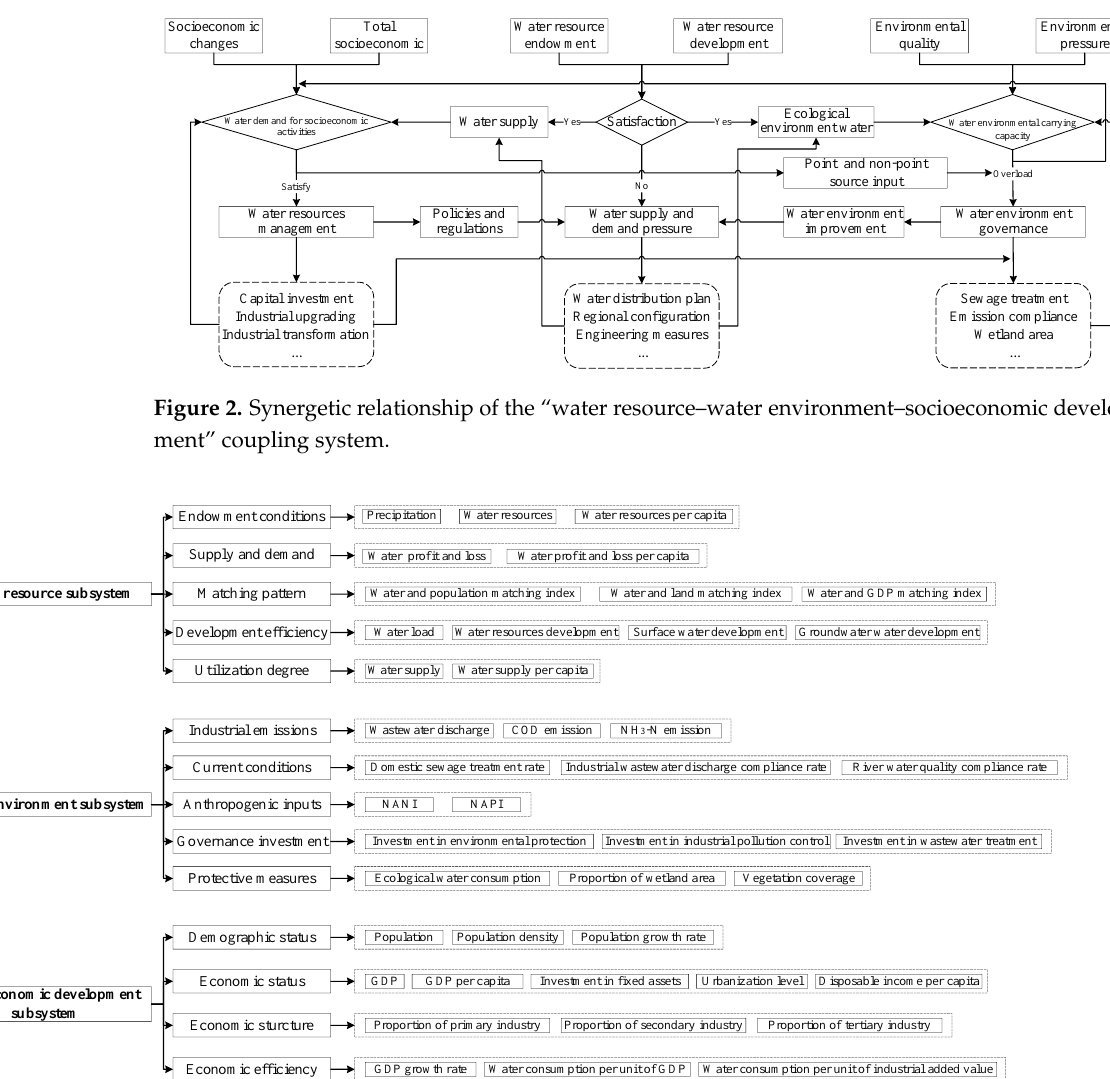
Figure 3. Evaluation index of the “water resource– water environment – socioeconomic develop- ment” coupling system.